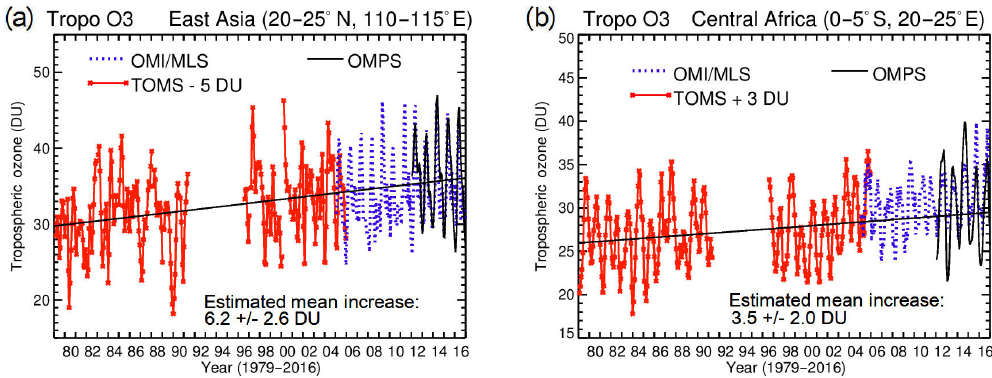
Figure 8. (a) Merged time series of TOMS/OMI/MLS/OMPS TCO for 1979–2016 over East Asia centered at 22.5 ◦ N and 112.5 ◦ E (5 ◦ × 5 ◦ region). The solid red curve is TOMS TCO and dashed blue curve is OMI/MLS. OMPS TCO (solid black curve) is also over-plotted with OMI/MLS TCO starting with 2012 for comparison. A constant adjustment of about − 5DU (using year 2005 coincident overlap data) was applied to the TOMS measurements for plotting with OMI/MLS. Both OMI/MLS and OMPS TCO also included offsets of + 2 and − 2DU following comparisons with ozonesonde measurements (see Supplement). The indicated total increase of 6.2DU was estimated using a regression best-fit line (black line shown) to the TOMS/OMI/MLS merged time series and agrees well with the 6–7DU net increase for this region in Fig. 7. (b) Similar to (a) except for central Africa centered at 2.5 ◦ S, 22.5 ◦ E and a TOMS offset of + 3DU. The line-fit increase is slightly smaller than the 4–5DU in Fig. 7. The estimated mean increases in both panels include calculated 2 σ